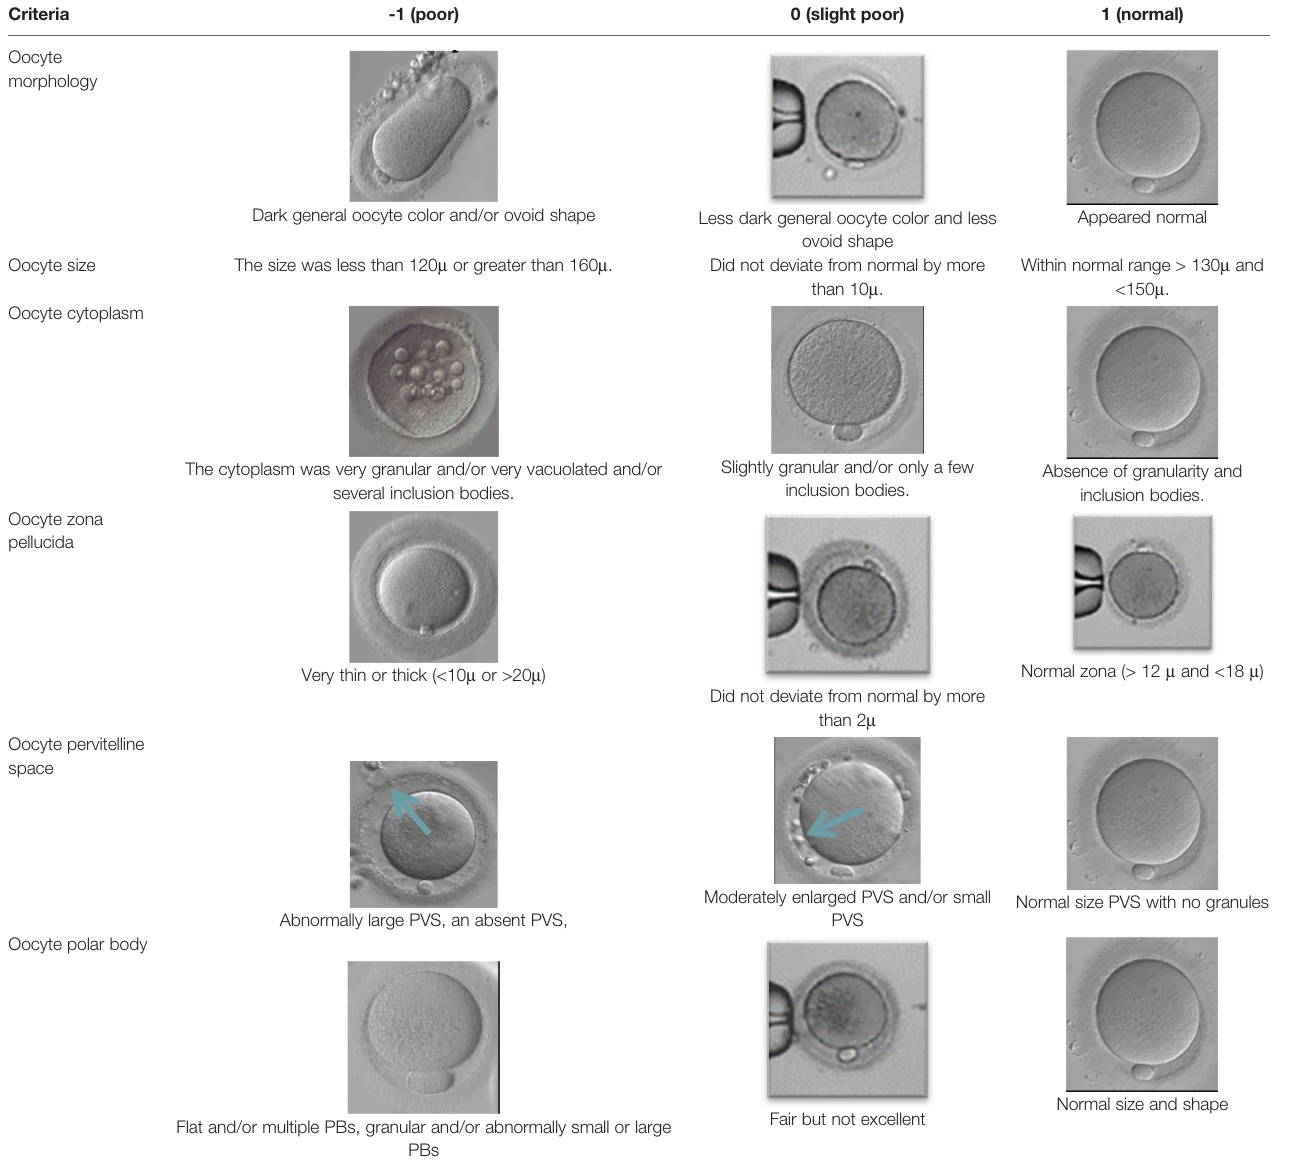
TABLE 1 | The fi gure represents the oocyte grading system for the six morphological characteristics analyzed.